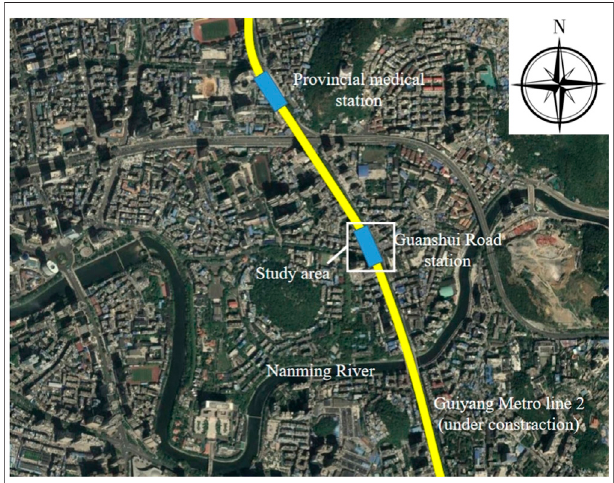
FIGURE1| SchematicdiagramofthelocationofGuanshuiRoadStation